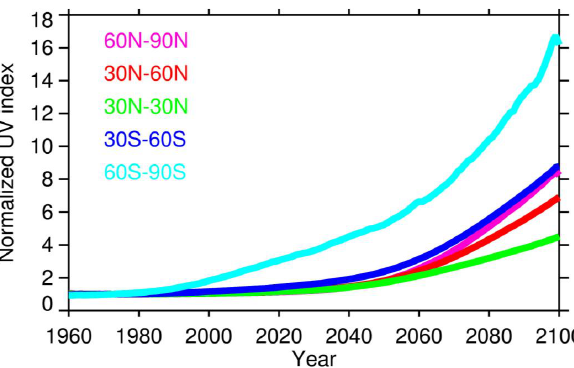
Fig. 12. Changes of erythemal weighted UV irradiances for five latitudinal bands 90 ◦ N–60 ◦ N (blue), 60 ◦ N–30 ◦ N (green), 30 ◦ N– 30 ◦ S (red), 30 ◦ S–60 ◦ S (light blue) and 60 ◦ S–90 ◦ S (violet) in September relative to the 1970–1979 average for the noMPA sce-